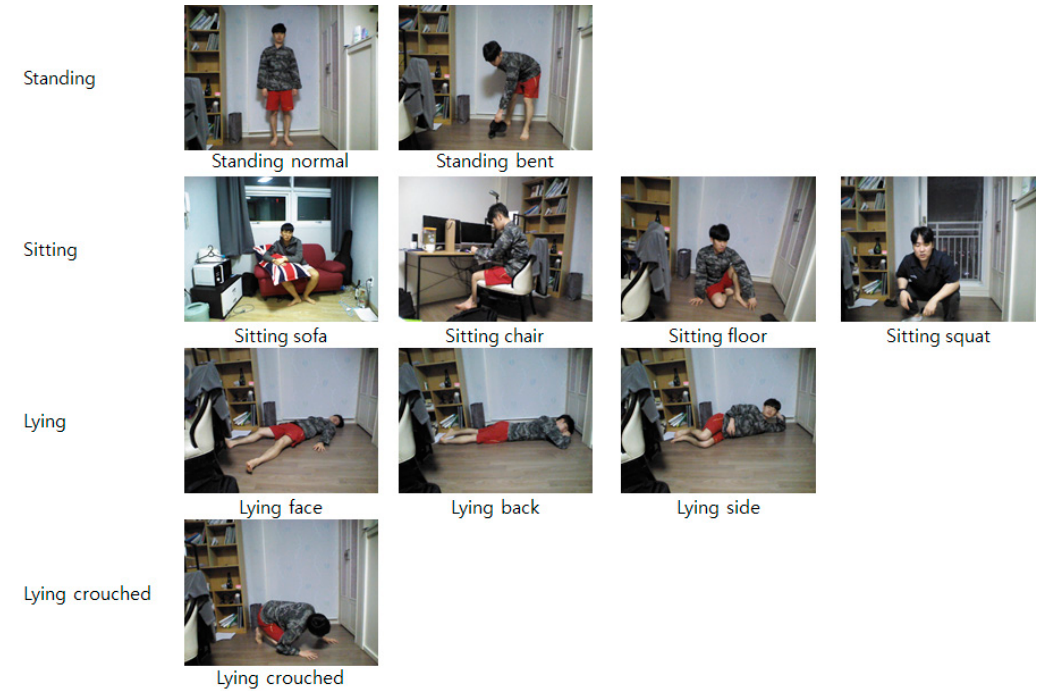
Figure 14. Examples of four categories with 10 postures.